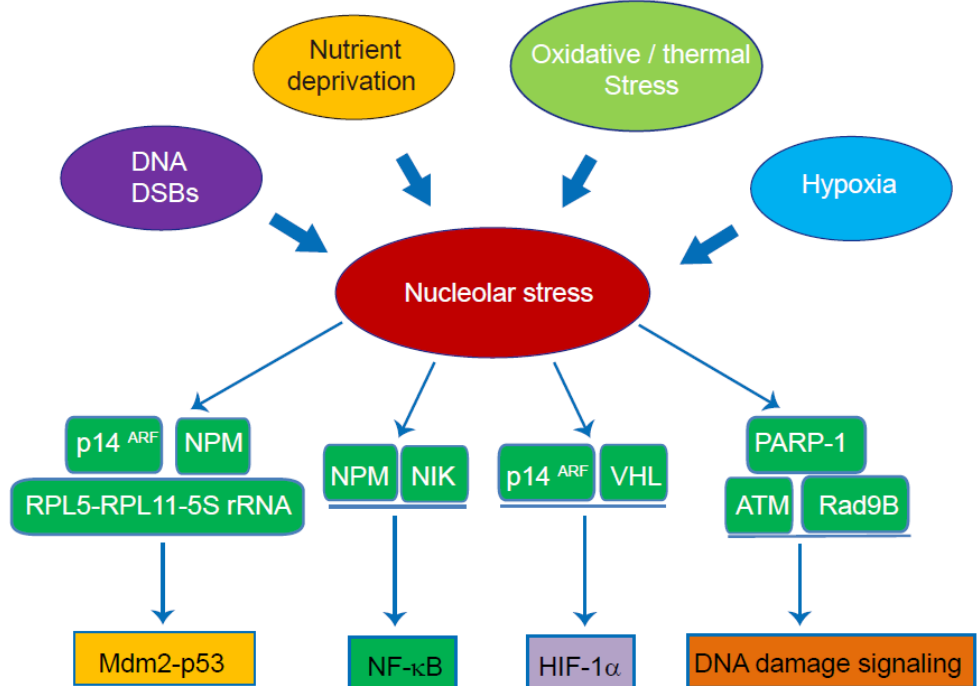
Figure 2. The role of nucleolar stress in transducing stress-related pathways. Nucleolar stress is initiated by various stress conditions, including DNA DSBs, nutrient deprivation, hypoxia, oxidative and thermal stress. Under these stress conditions, the nucleolus may modulate the transduction of various stress-associated pathways via aberrant nucleolar sequestration or release of different regulators.